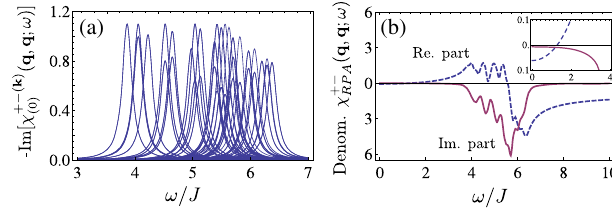
FIG. 4. Transverse spin susceptibility for U ¼ 5 J and q ¼ ð π =a; 0 Þ computed with a finite convergence factor δ ¼ 0 . 1 J in a 20 × 20 lattice. (a) We show for the MFT case, the individual þ − ð k Þ ð q ; q ; ω Þ of Eq. (42), χ þ − ð q ; q ; ω Þ ¼ momentum terms χ ð 0 Þ ð 0 Þ P χ þ − ð k Þ ð q ; q ; ω Þ . Each term contributes with a Lorentzian- k ð 0 Þ shaped peak at ω ¼ E k − E k þ q . (b) Imaginary (solid line) and real (dashed line) parts of the denominator in the RPA case χ þ − ð q ; q ; ω Þ [Eq. (47)]. The inset in (b) zooms in close to the RPA origin and shows the zero crossing in the real